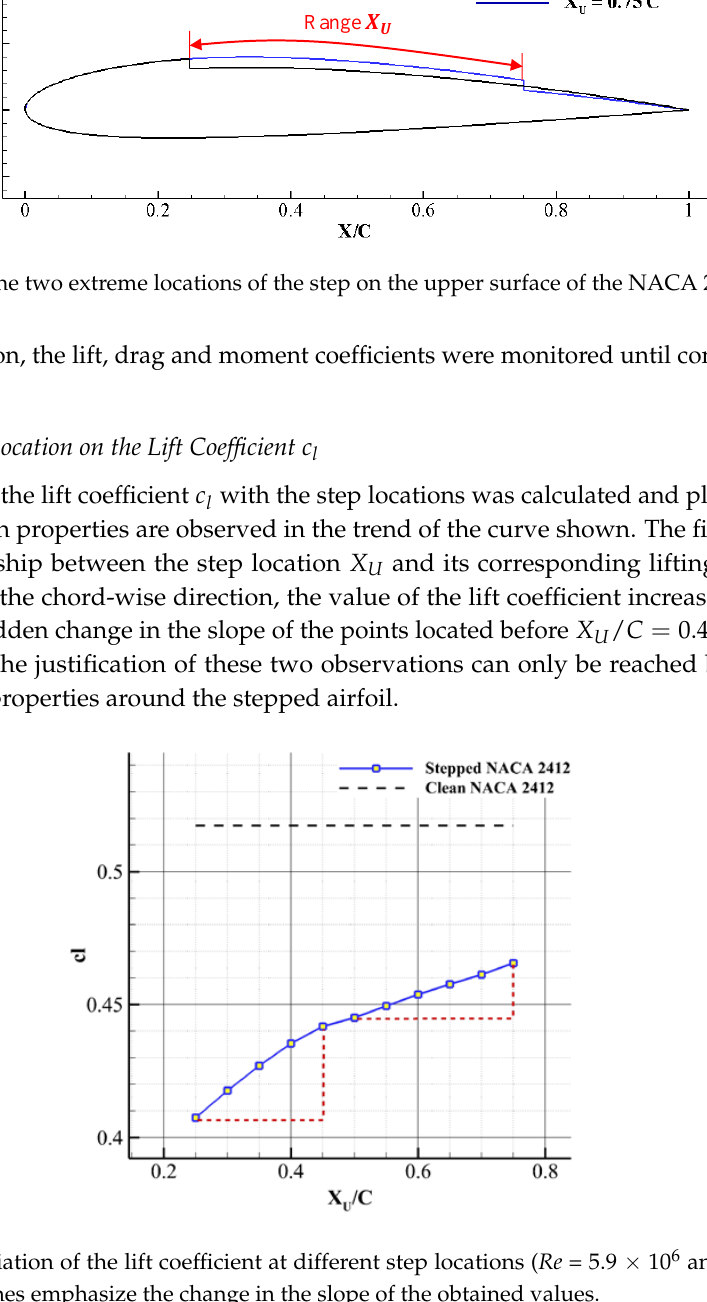
and ). 6 and ). 𝑅𝑅𝑅𝑅 = 5.9 × 10 𝛼𝛼 = 2.5° 6 𝑅𝑅𝑅𝑅 = 5.9 × 10 𝛼𝛼 = 2.5°